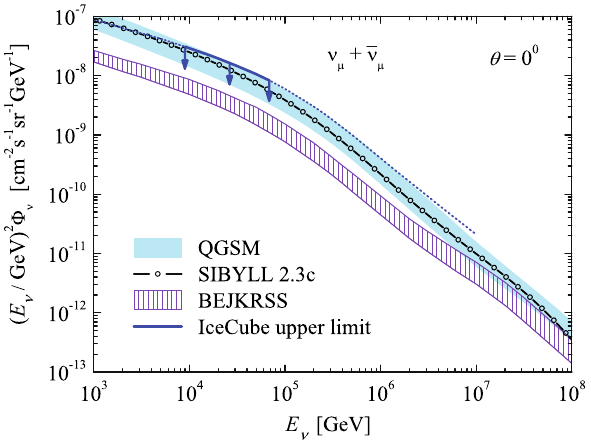
Fig. 18 The comparison of the prompt neutrino flux calculated for the H3a cosmic-ray spectrum [56] with use of different models: QGSM ( α ψ ( 0 ) = − 2 . 2), SIBYLL 2.3c [23], the pQCD models BEJKRSS [24] and GRRST [25]. Solid line is the IceCube constraint, dotted line plots the limit extrapolation